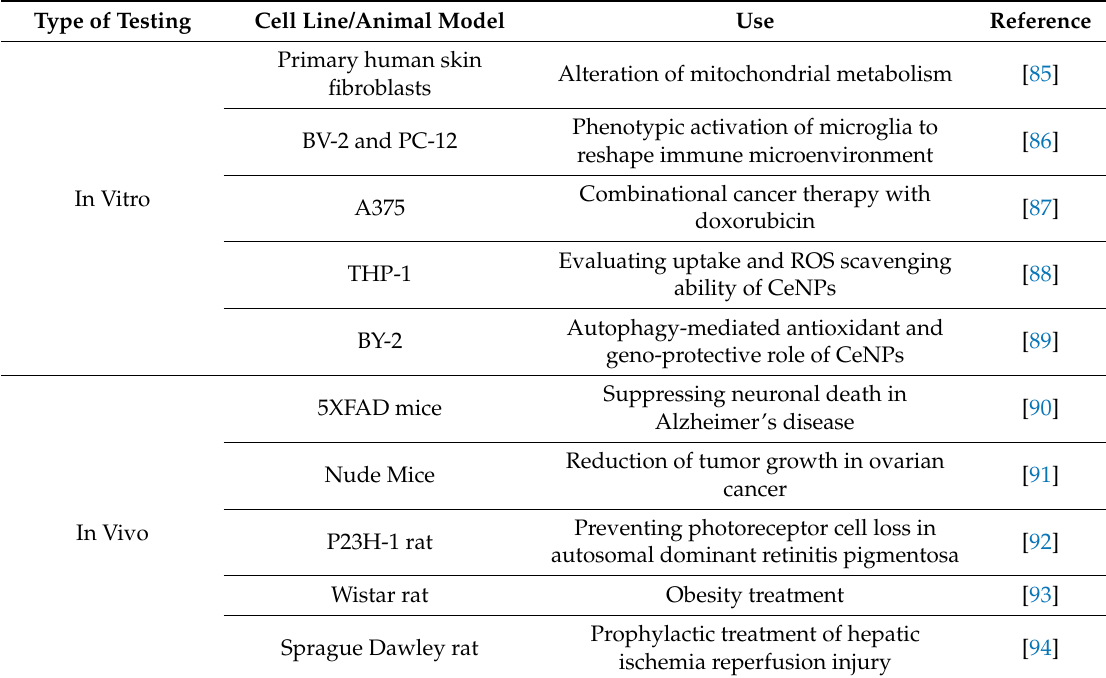
Table 2. Recent literature on the biomedical studies involving cerium oxide nanoparticles (CeNPs). Type of